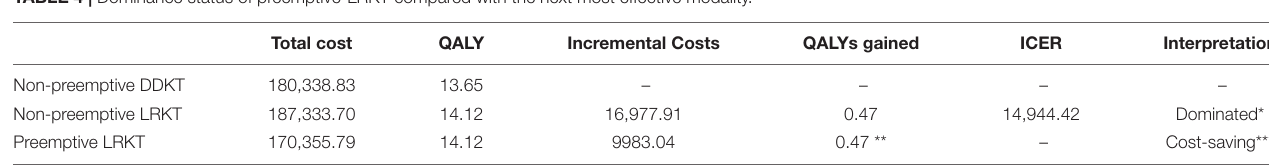
TABLE 4 | Dominance status of preemptive-LRKT compared with the next most effective modality.